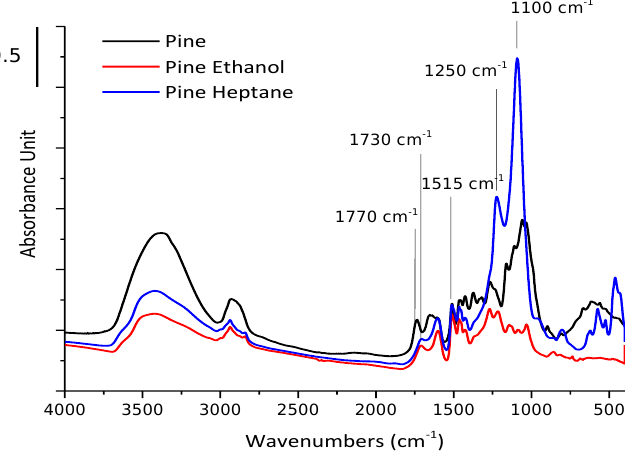
Figure 2. FTIR spectra of solid residues recovered after pine wood fractionation in SC ethanol at 250 °C and in SC n-heptane at 280 °C for 1 h. Comparison to FTIR spectra of fresh pine wood.